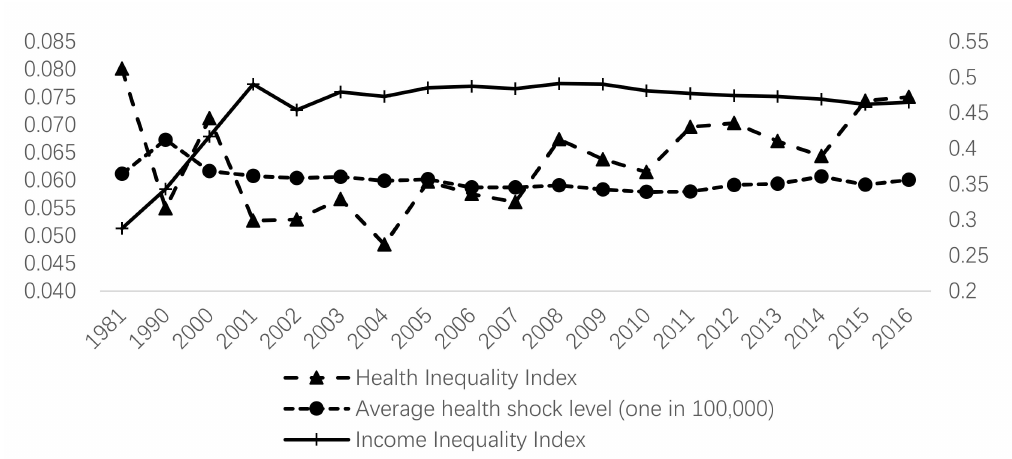
Figure 4. The annual development trend of residents’ income and health in China. Note: We used the geometric mean of the mortality rates in each province to represent the average health level, and adopted the annual income Gini coefficient to represent the income inequality index, and calculated the health inequality index in the sample using the Gini coefficient